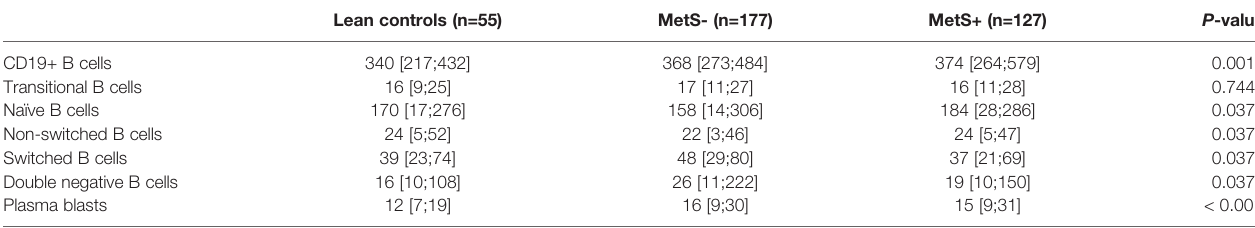
TABLE 2B | Absolute numbers of the B cell